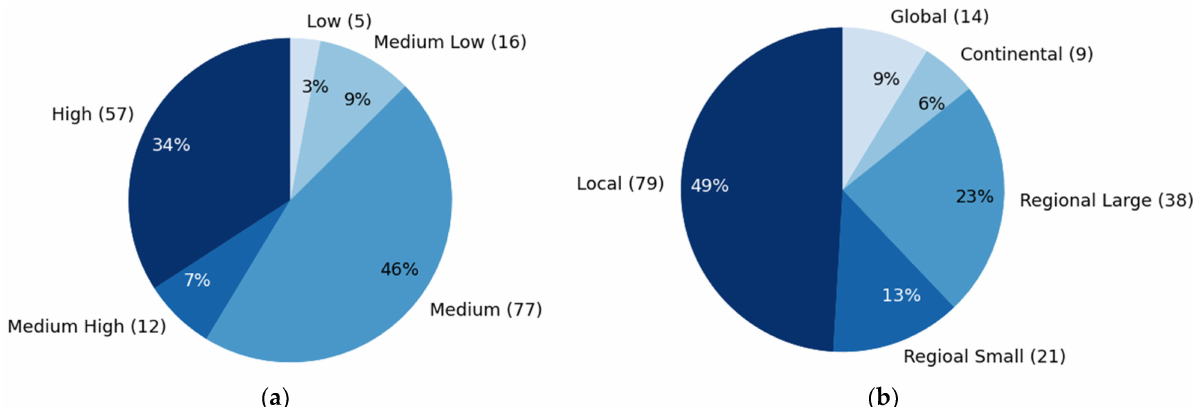
Figure 8. ( a ) Distribution of applied spatial resolutions of the reviewed studies. The spatial resolutions are classified into High (30–120 m), Medium–High (120–1000 m), Medium (1000–4000 m), Medium– Low (4000–10,000 m) and Low (>10,000 m). ( b ) Distribution of the spatial scales of the reviewed articles. The scales are classified into local (<15,000 km 2 ), regional small (15,000–250,000 km 2 ), regional large (>250,000 km 2 ), continental (including one or multiple continents) and